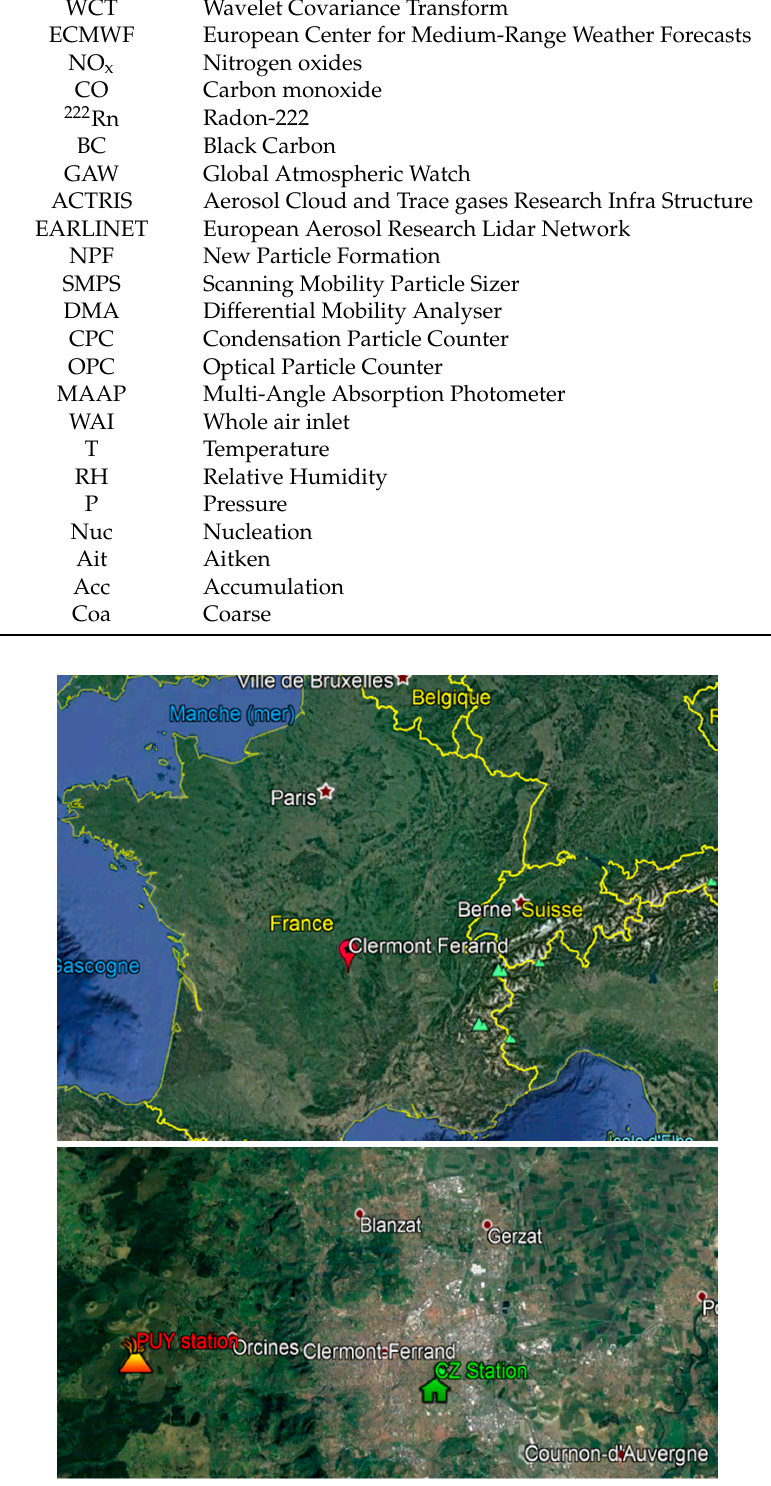
Figure A1. ( Top ) The regional map of Clermont-Ferrand; ( bottom ) Zoom on Clermont-Ferrand city. The green house represents the CZ station, and the orange volcano represents the PUY station. (Adapted from Google Earth).